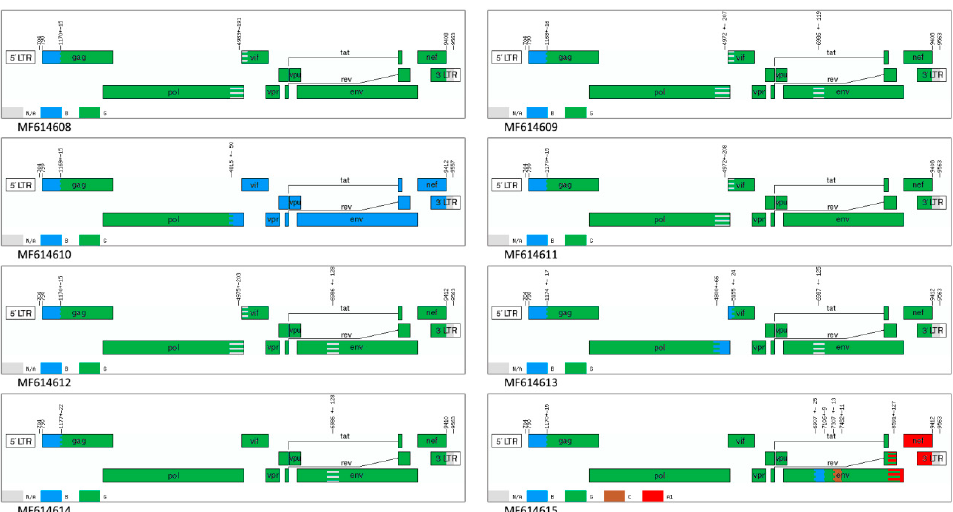
Figure 3. Scheme of the location of recombination patterns according to the jpHMM (jumping profile Hidden Markov Model) results. The patterns of homology are shown as follows: the G subtype is highlighted in green, the B subtype is highlighted in blue, the C subtype is highlighted in brown, the A1 subtype is highlighted in red and the unknown subtype (uncertain regions) is highlighted in grey.